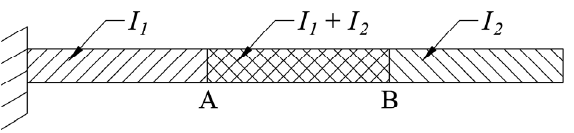
Figure 4. Schematic of uniform beam with equivalent area moment of inertia. 𝐼 𝐼 (cid:2869) and (cid:2870) in Figure 4 represent the equivalent area moment of inertia of the outer cylinder and the piston rod, respectively. In the xoz plane and the yoz plane, the outer